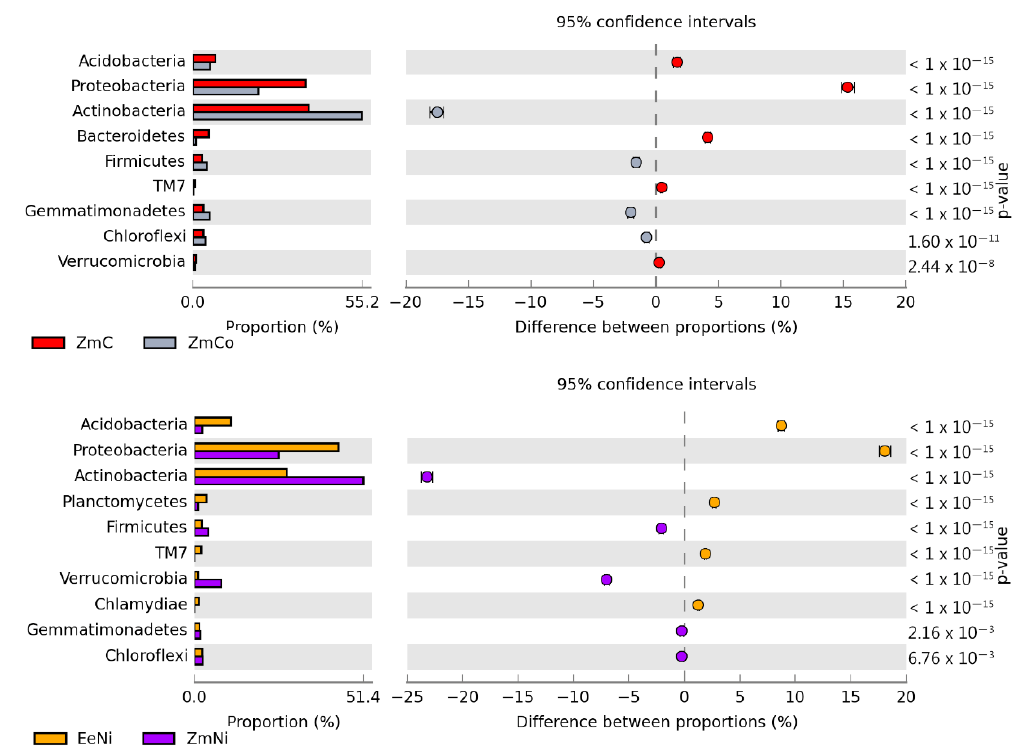
Figure 6. Relative abundance of bacterial phyla with OTU ≥ 1% in the soil polluted with heavy metals. Ee— Elymus elongatus